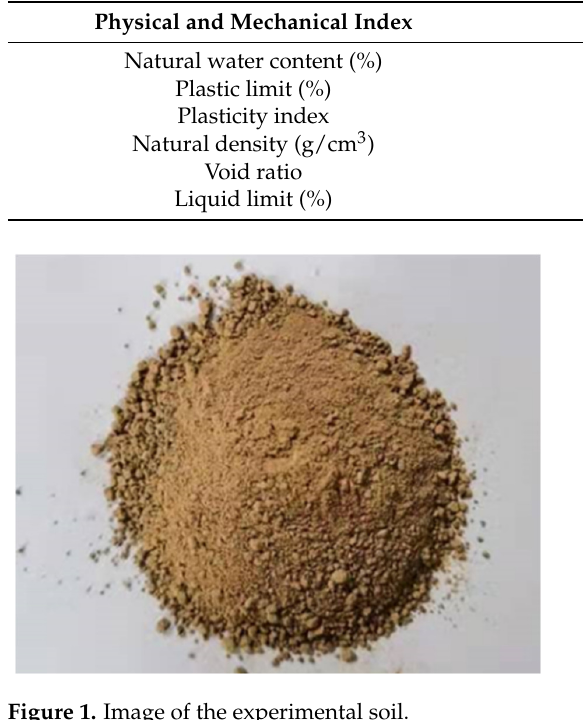
Figure 1. Image of the experimental soil.